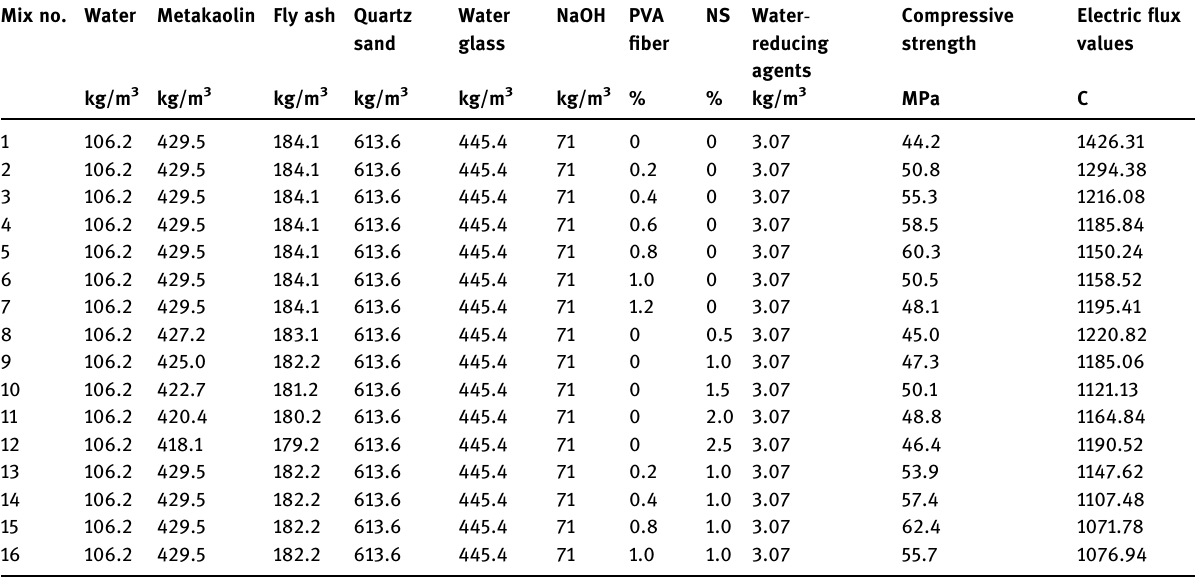
Mix no. Water Metakaolin Fly ash